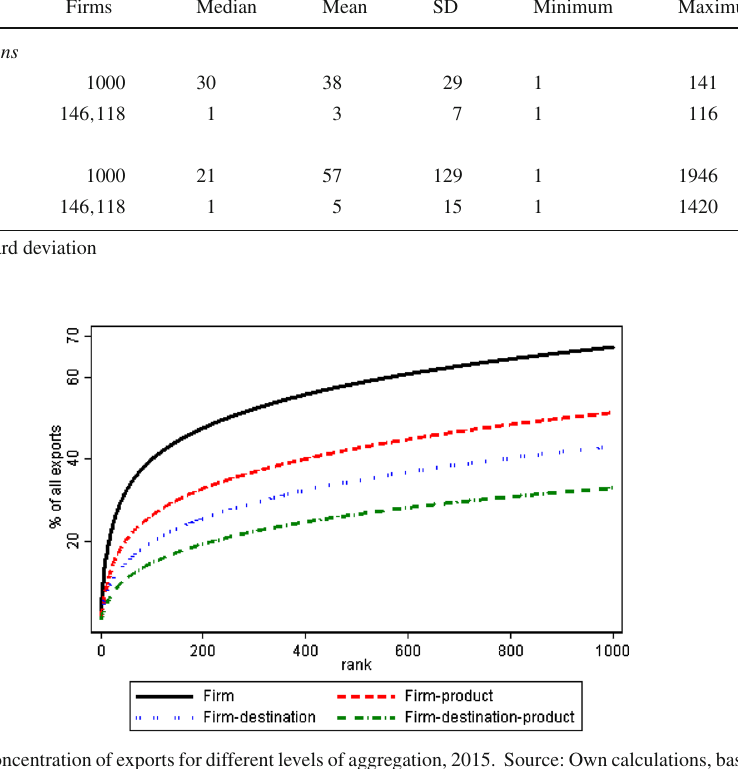
Fig. 2 Concentration of exports for different levels of aggregation, 2015. Source: Own calculations, based on the Customs